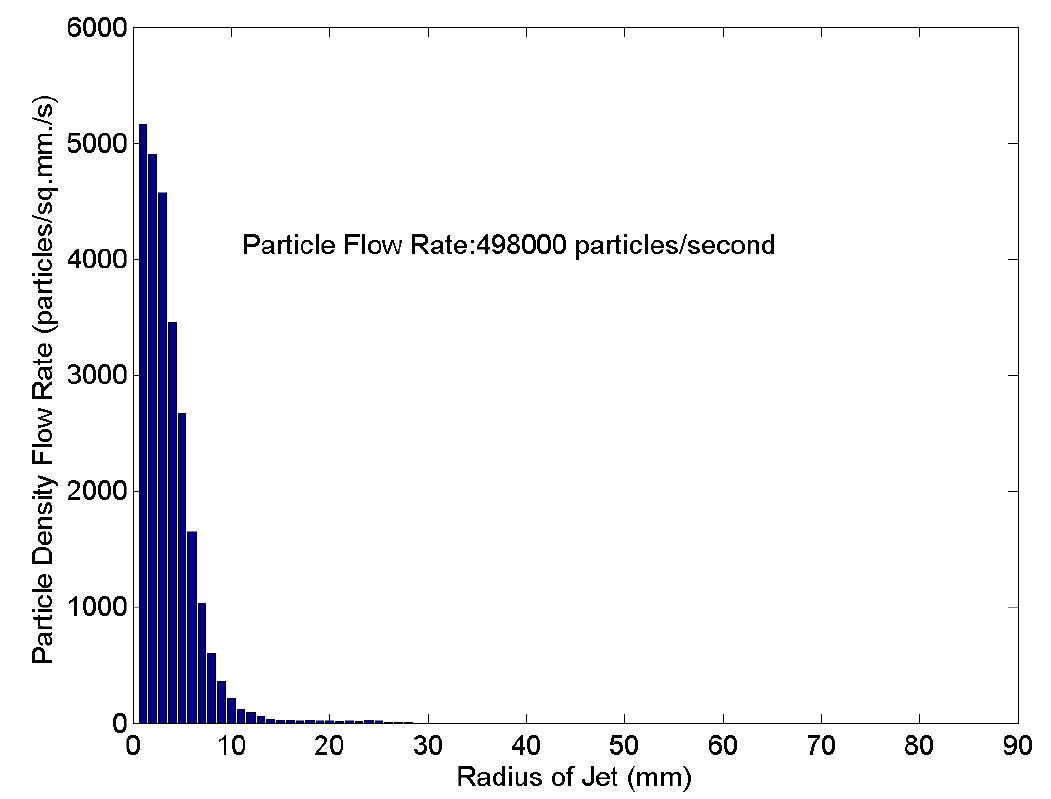
Figure 17. Experiment 2: Radial particle distribution at 10 cm from origin of annular air jet. Exposure time: 200 μ